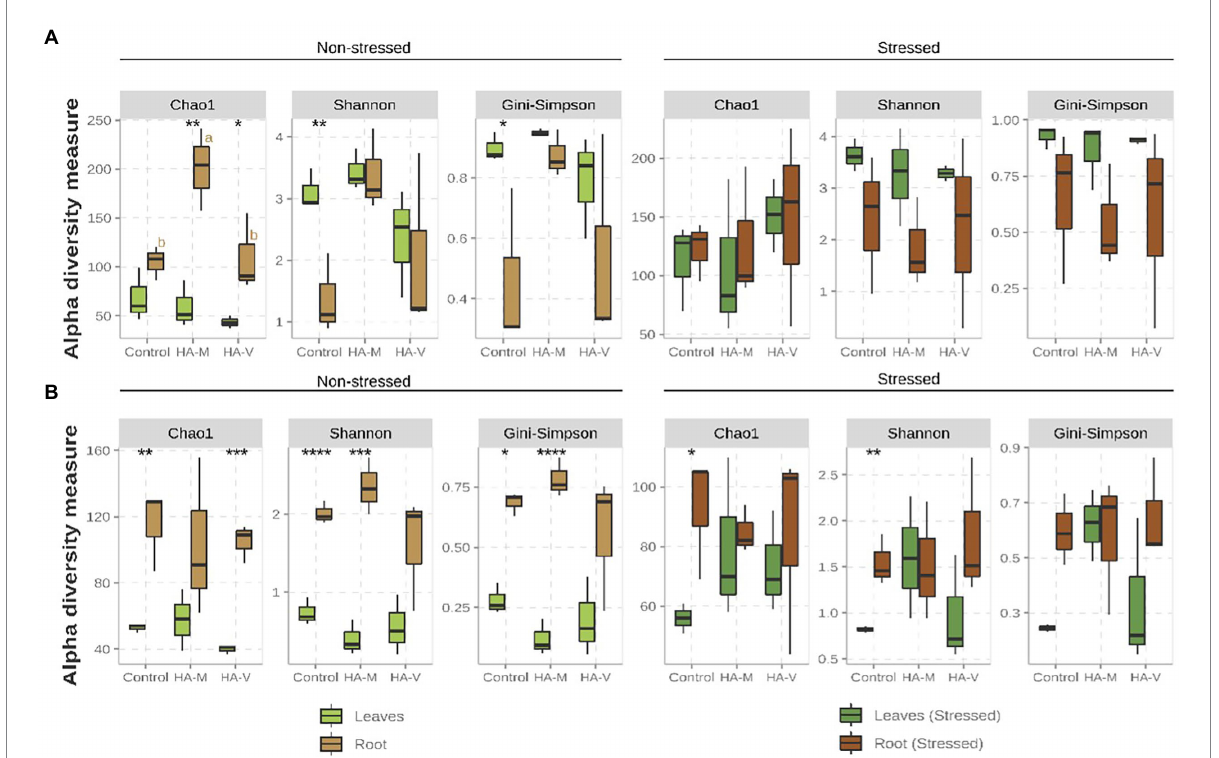
FIGURE 1 Boxplot of the alpha diversity metrics of bacterial (A) and fungal (B) fractions present in the shoot and root of soybean plants that received the application of vermicompost HA (HA-V), millicompost HA (HA-M) or that did not receive application (Control) in the presence and absence of stress. Different letters indicate significant differences between HA application within the same plant material ( post-hoc test). Significant differences between different plant tissues under the same conditions (HA application and presence or absence of stress) can be seen by the presence of the following symbols: **** p < 0.001; *** p ≤ 0.01; ** p ≤ 0.05; * p ≤ 0.1. The absence of letters/symbols indicates no significant differences between